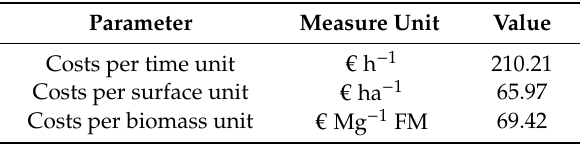
Table 5. Results of costs analysis.